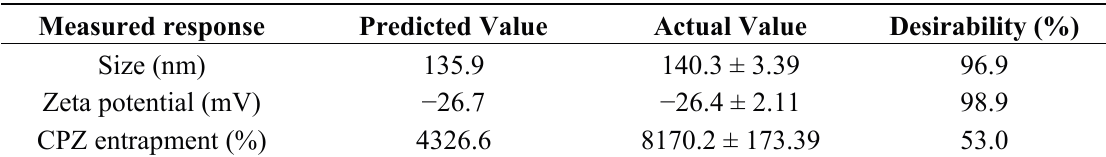
Table 5. Predicted, experimental and desirability values of the CPZ-Loaded, PCL based nanocapsule formulation.